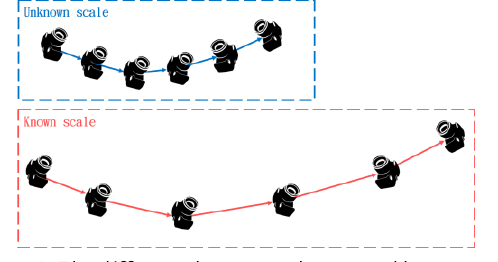
Figure 2. The difference between unknown and known